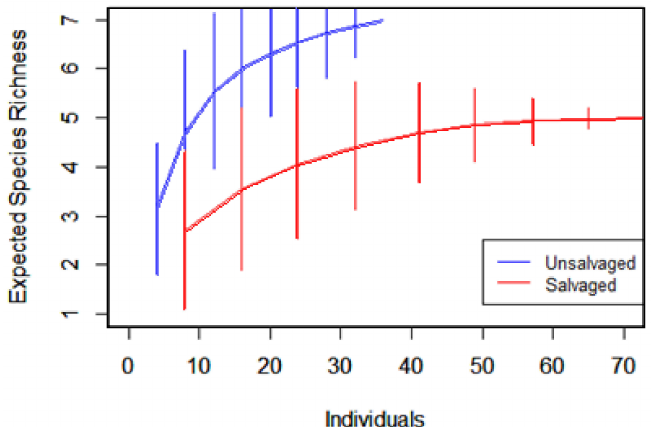
Figure 6. Species accumulation curve based on individual saplings in salvaged ( red ) and unsalvaged ( blue ) plots six years post-disturbance.